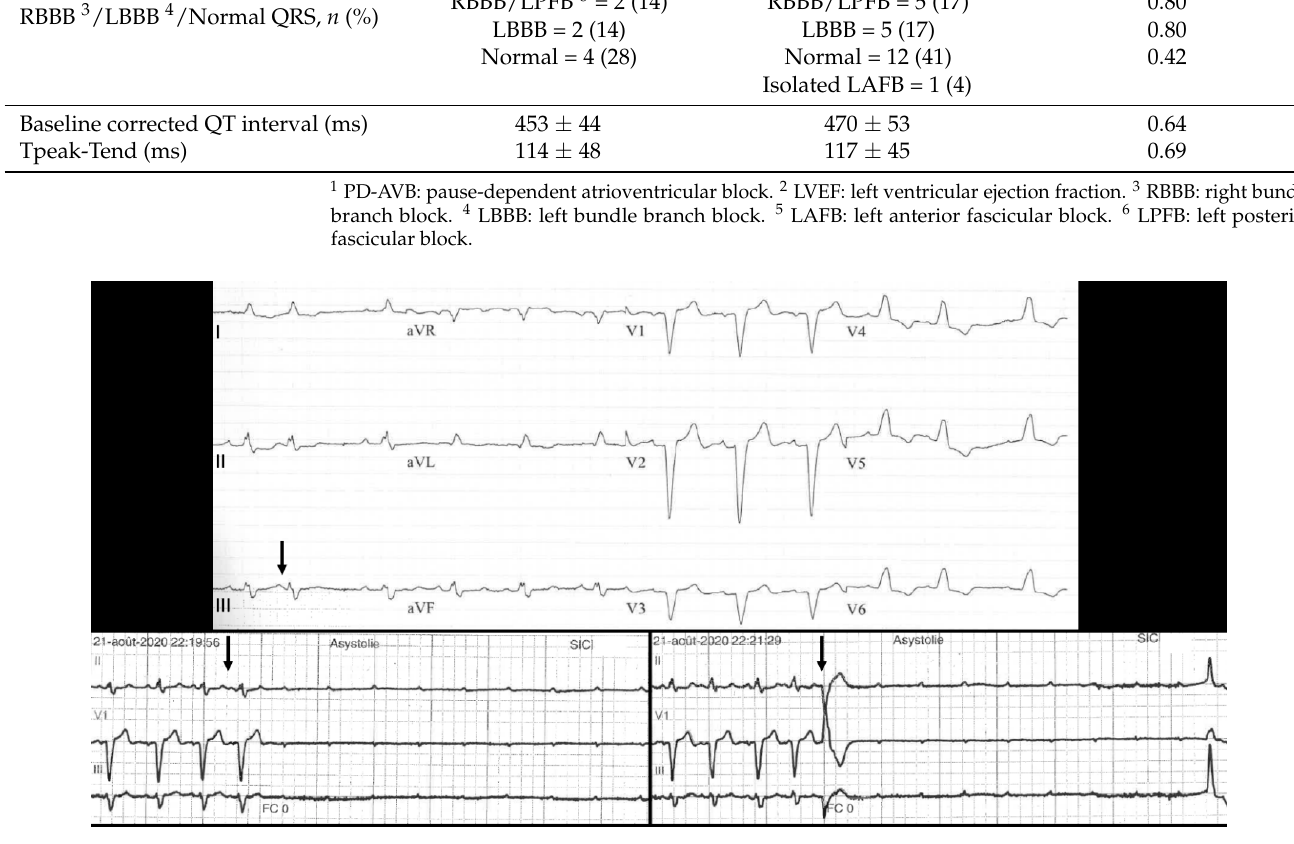
Figure 3. Example of two mechanisms of pause-dependent atrioventricular block seen within the same patient (patient 10 in Table 2). Baseline twelve-lead ECG shows sinus rhythm with complete left bundle branch block and a conducted premature atrial contraction (PAC). Another timely-ap- propriate PAC then induced PD-AVB (left lower image). Another PD-AVB episode was recorded after a premature ventricular contraction (lower right image). Table 2. Summary of published cases of pause-dependent atrioventricular